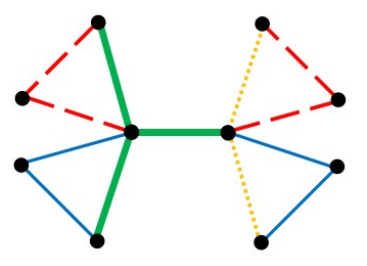
Figure 1: The bow-tie graph B and a 4 -liec of